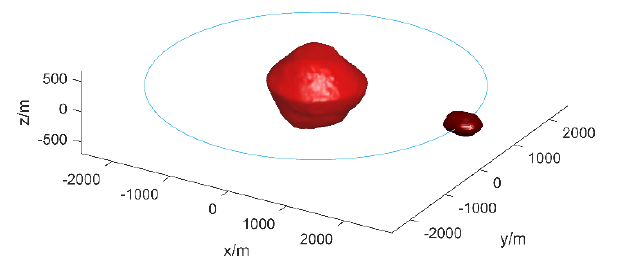
Figure 3. Dynamical configuration of binary asteroids 1999 KW4.